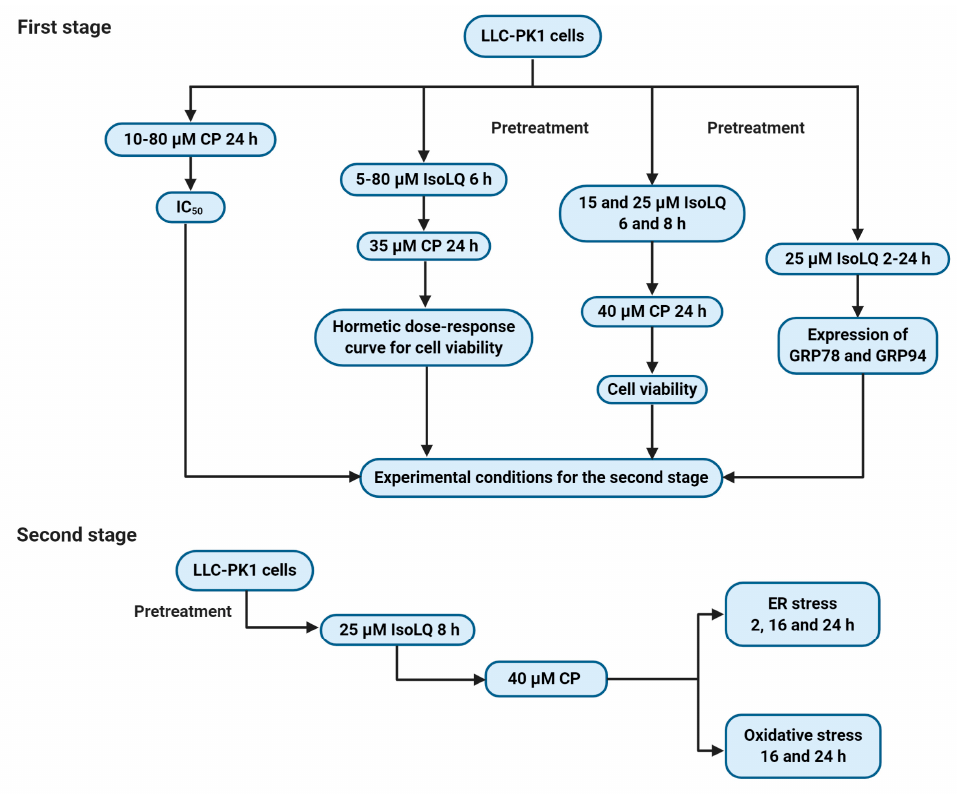
Figure 9. Scheme of the experimental design. CP, cisplatin; IsoLQ, isoliquiritigenin; GRP78, glucose-regulatedprotein78kDa; GRP94, glucose-regulatedprotein94kDa; ER,endoplasmicreticulum. Figurewas created with